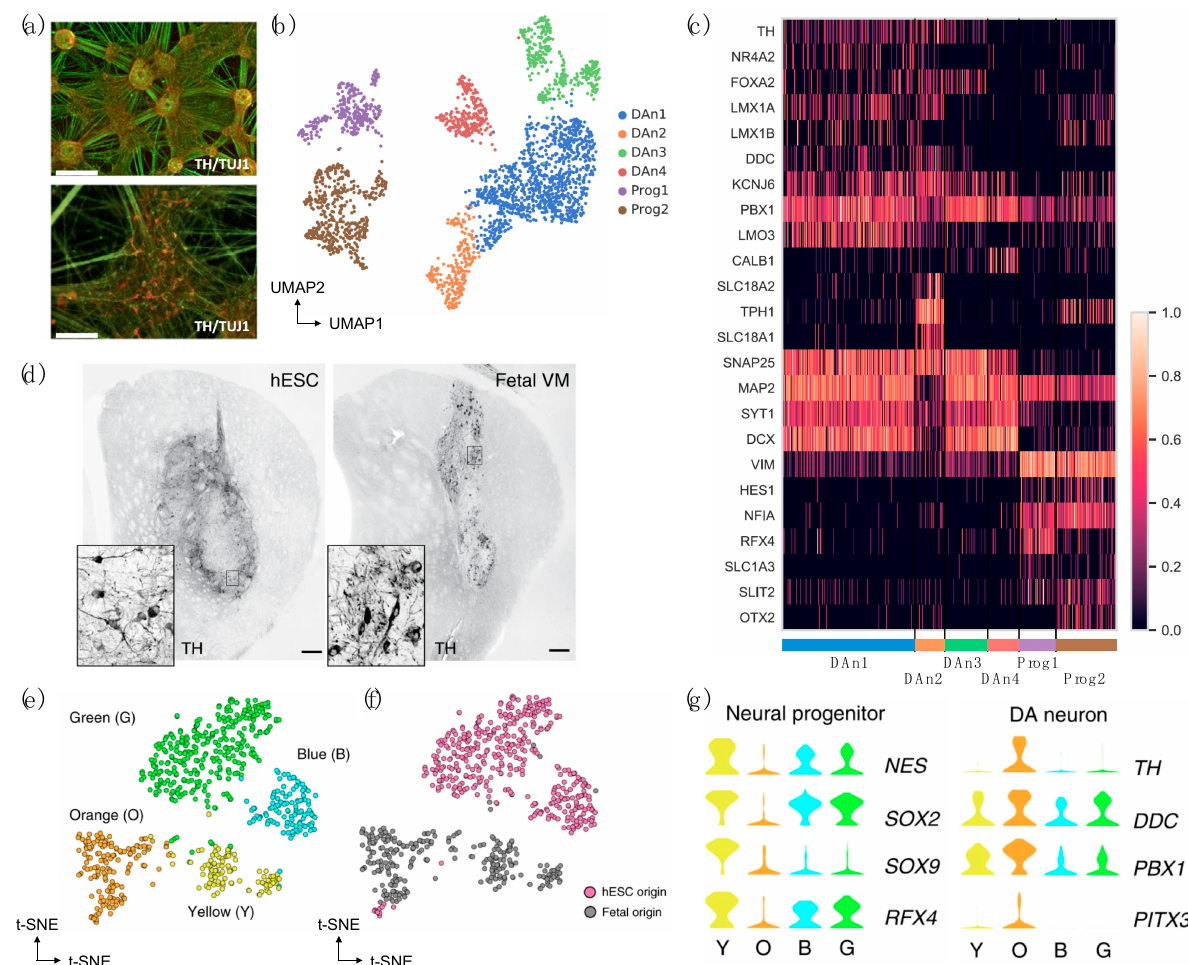
Figure 2. scRNA-seq of fetal and human induced pluripotent stem cell (hiPSC) or embryonic stem cell (ESC)-derived neurons in studies of PD. ( a – c ) Use of WT hiPSC-derived DaNs. Reprinted from [31], Copyright 2020 Elsevier. ( a ) Immunofluoresence staining, ( b ) Uniform manifold approxiamation and projection (UMAP) and ( c ) expression heatmap of WT hiPSC-derived DaNs. TH: tyrosine hydroxylase, TUJ1: beta-3-tubulin. ( d – g ) Use of human embryonic stem cell (hESC) and fetal ventral midbrain (VM)-derived progenitors. Reprinted from [35] , Copyright 2020, Katarína Tiklová et al. ( d ) Immunohistochemistry of TH in the graft core (six months post-transplantation) ( e , f ) t-SNE and ( g ) expression plot using the stated genes (before grafting). “Y”, “O”, “B”, and “G” indicate cell clusters shown in ( e ).